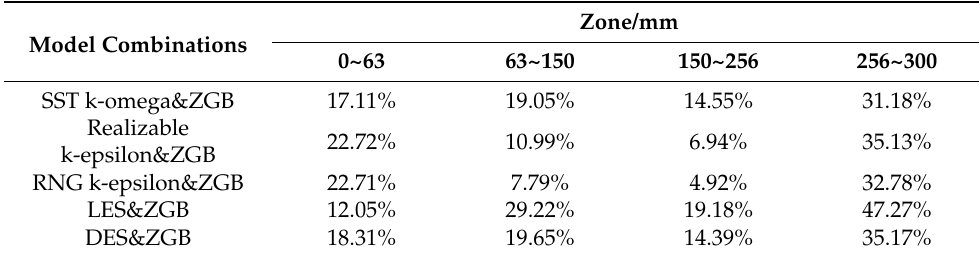
Table 8. The error of average cross-sectional x 2 flow rate at 67 bar differential pressure compared to test